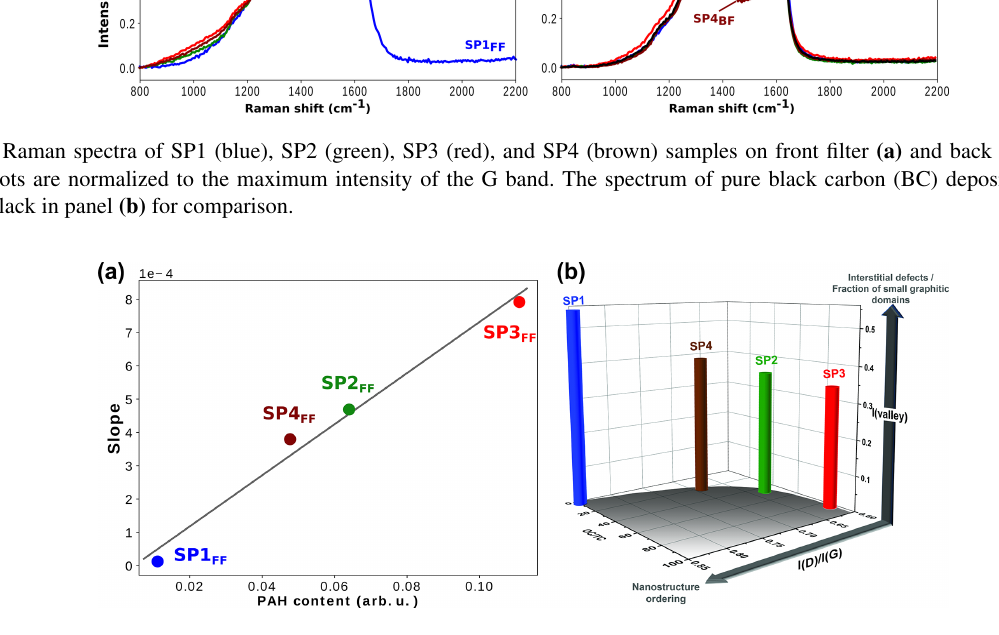
Figure 11. (a) Fluorescence slopes extracted from Raman spectra of SP1 FF – (blue), SP2 FF (green), SP3 FF (red), and SP4 FF (brown) plotted against total PAH content measured in L2MS (in terms of ion signal) in front filter samples, (b) 3-D bar plot showing the evolution of the intensity of the “valley” between the two D and G bands and that of the I( D )/I( G ) height-ratio with organic content (OC / TC ratio) in front filter